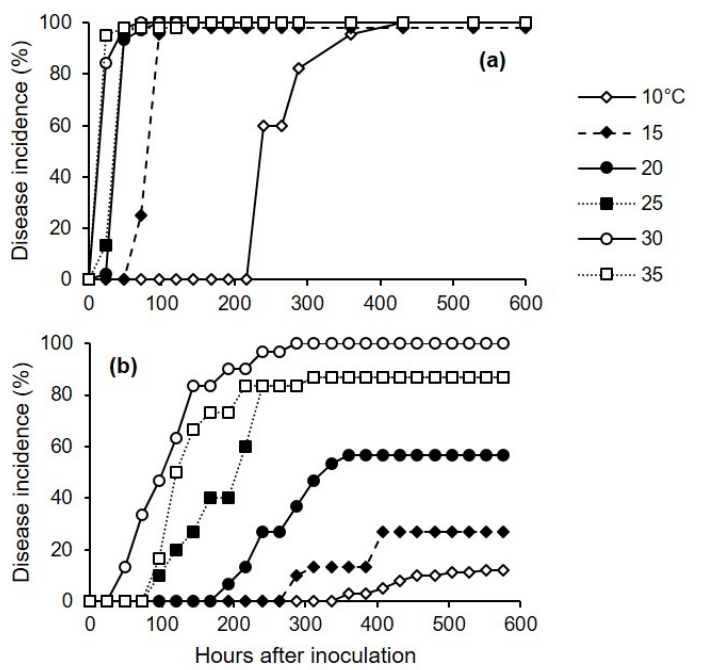
Figure 6. Percentage of injured ( a ) and uninjured ( b ) grape berries showing white rot symptoms following artificial infection with Coniella diplodiella conidia (experiment 3). After they were inoculated, berries were initially kept at 30 °C and with 100% relative humidity for 12 h to facilitate infection, and were then kept at one of the six indicated temperatures. The incubation period was longest at 10 °C, with IP 50 = 236 h for injured berries and 416 h for uninjured berries. The length of the incubation period decreased as temperature increased; at 30 °C, IP 50 = 14 h for injured berries and 101 h for uninjured berries (Figure 7). The following parameter estimates of Equation (5) fit the incubation data for injured clusters with R 2 = 0.98 and CCC= 0.98: IP 50 min = 16 h, Tmin = 5.5 °C, Topt = 30 °C, and Tmax = 41.5 °C (Figure 7a). Estimates for uninjured clusters (with R 2 = 0.80 and CCC = 0.85) were IP 50 min = 101 h, Tmin = 1 °C, Topt = 30 °C, and Tmax = 43.5 °C (Figure 7b).